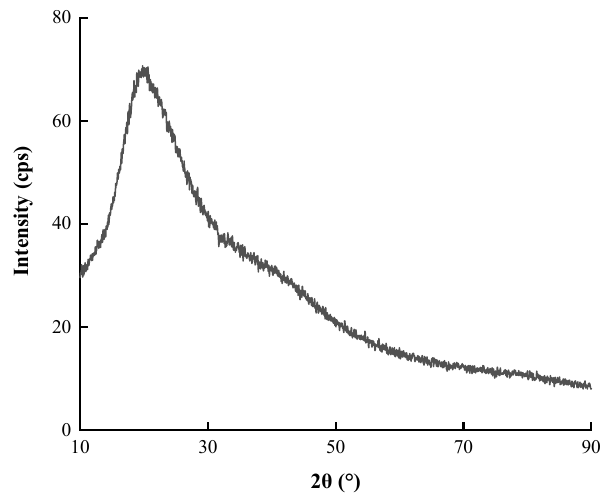
Figure 8. XRD spectrum of PtNPs.